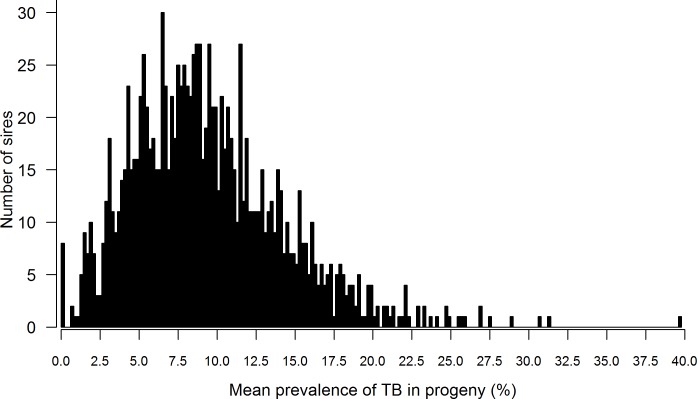
Distribution of the mean prevalence of bovine tuberculosis in the progeny of 1,262 sires that produced at least 50 progeny in 10 bovine tuberculosis-breakdowns.